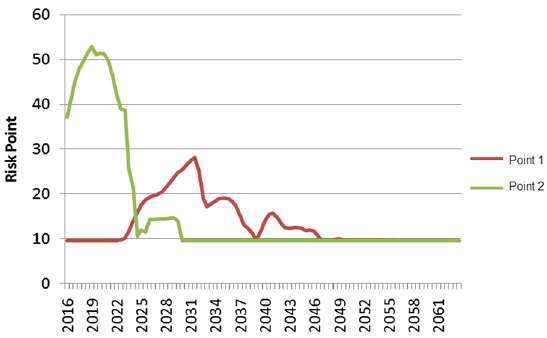
Fig. 9 Distribution of risk in time for selected points along the pipe-